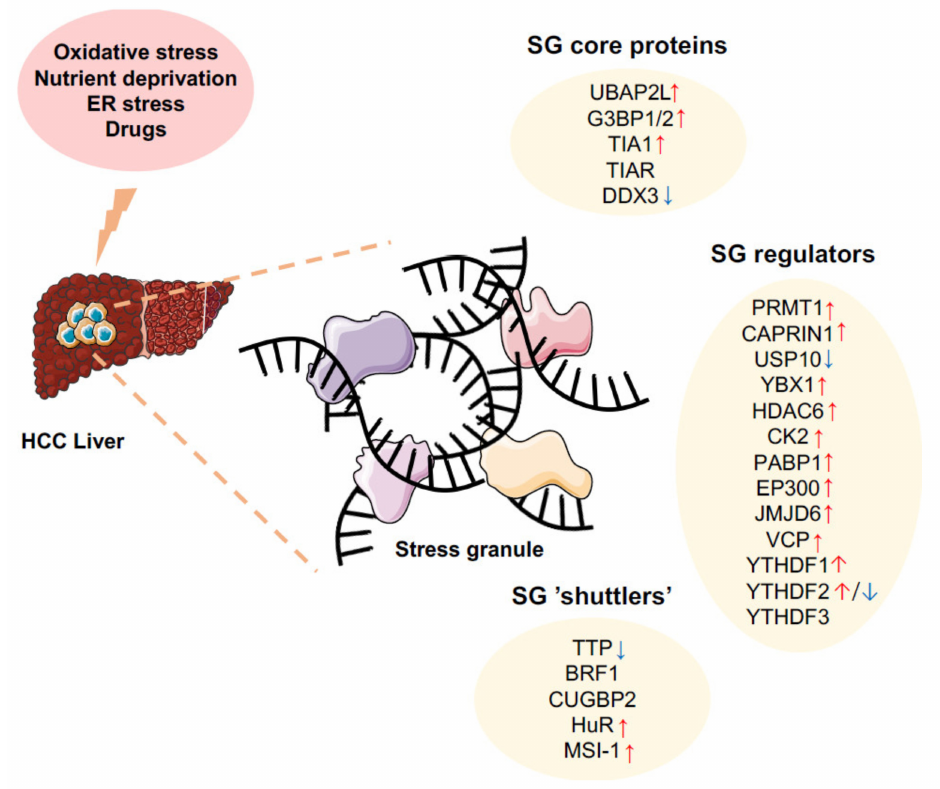
Figure 4. Alterations of SG components in hepatocellular carcinoma. Hepatocellular carcinoma is associated to the alteration of several SG components (core proteins, SG regulators, and SG shuttlers). Together, these alterations may importantly contribute to SG formation upon cellular stresses (e.g., oxidative stress, nutrients deprivation, ER stress, drugs). SG may in turn alter cell survival and death, angiogenesis, and other cancer-related processes. Arrows indicate higher (red) or lower (blue) expression in HCC based on literature (see respective